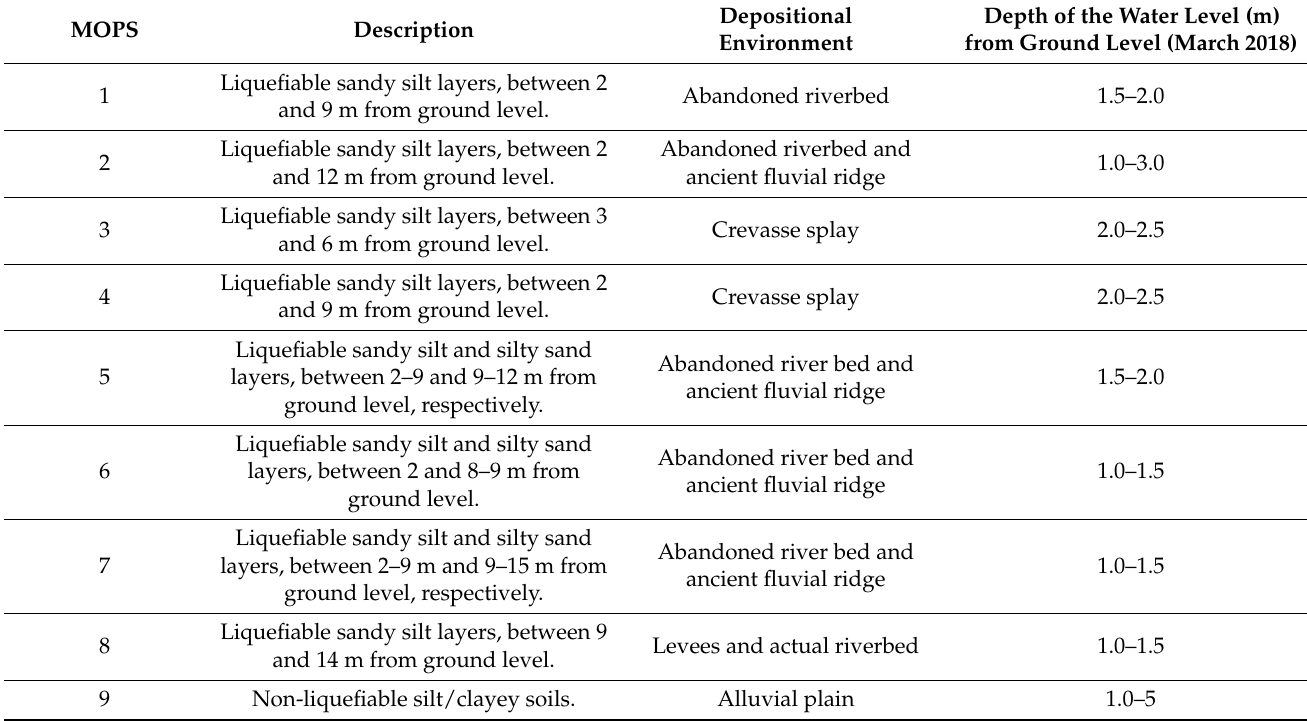
Table 2. Lithological and geomorphological characteristics of the MOPS in